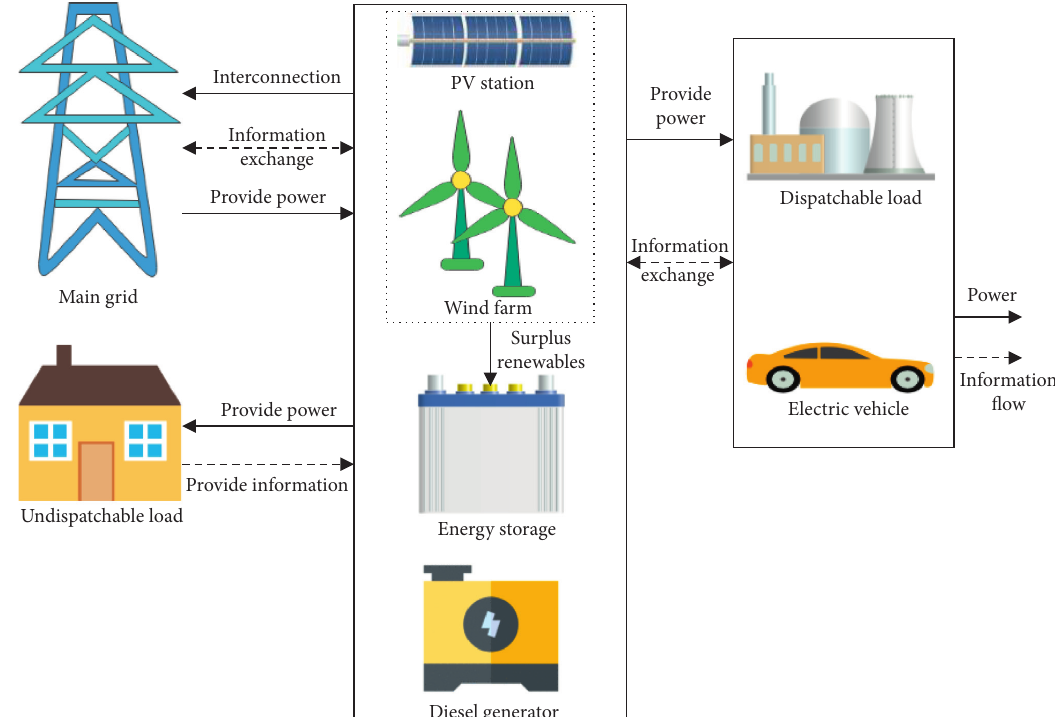
Figure 1: WT-PV-ES-DG-EV hybrid power system with the dispatchable